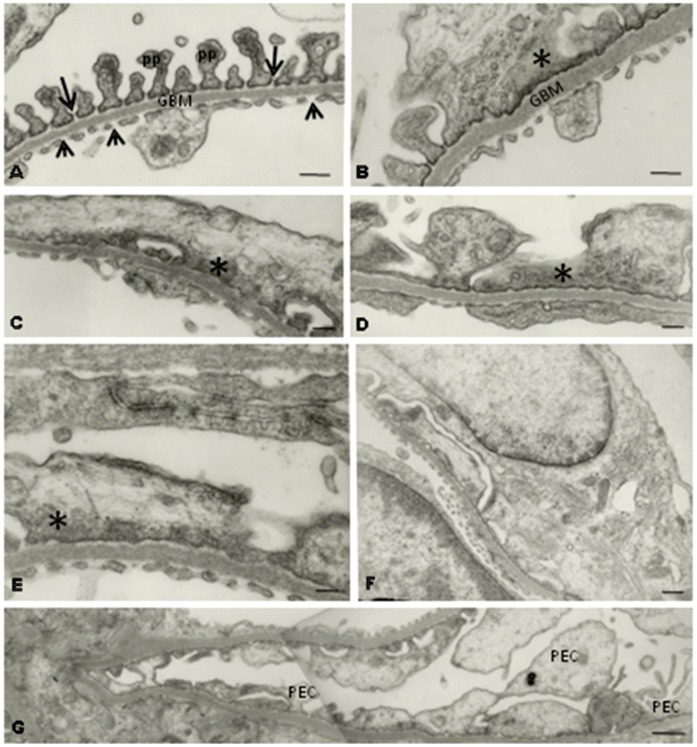
Transmission electron micrographs showing: A) the filtration barrier from NP glomeruli (from 5 rats) showing all the structural components of the filtration barrier, including the fenestrations of the glomerular endothelium (arrowheads), the GBM, the podocyte pedicels (pp) and the filtration slits crossed by tenuous diaphragm membranes (arrows).B–F) the filtration barrier from LP glomeruli (from 5 rats) showing a drastic decrease in the number of pedicels and slit diaphragms. Irregular electron-dense masses occur in the podocyte cytosol. Note in B the increased thickness of GBM compared to what is observed in A–G) in LP glomeruli, we found PECs in the process of differentiating into podocytes.